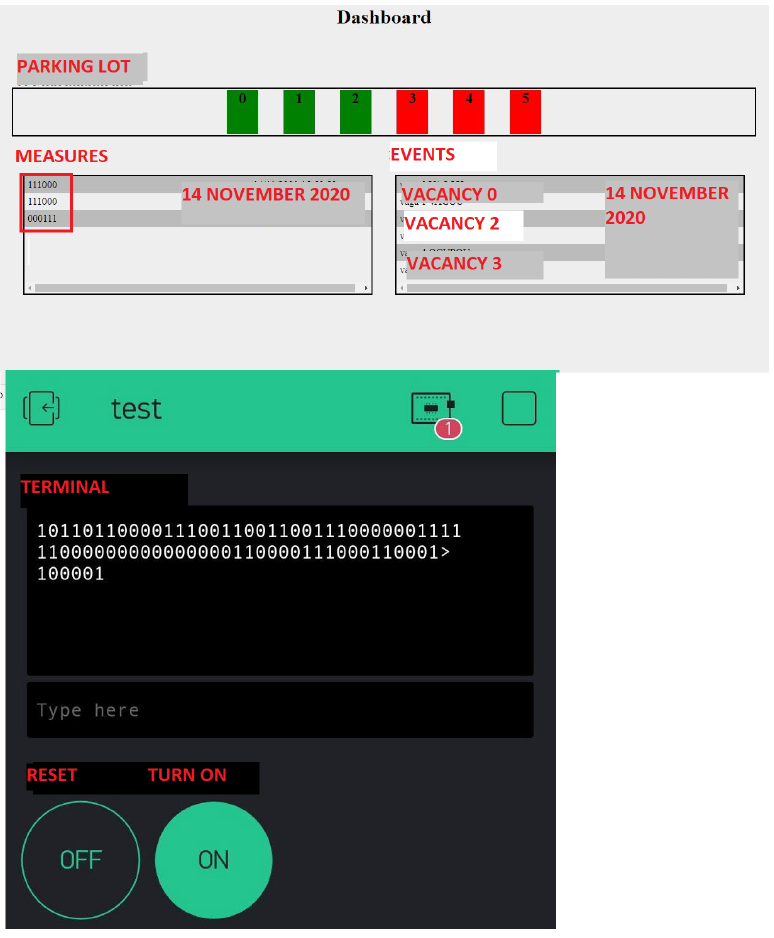
Figure 9. Vacancy Sensor